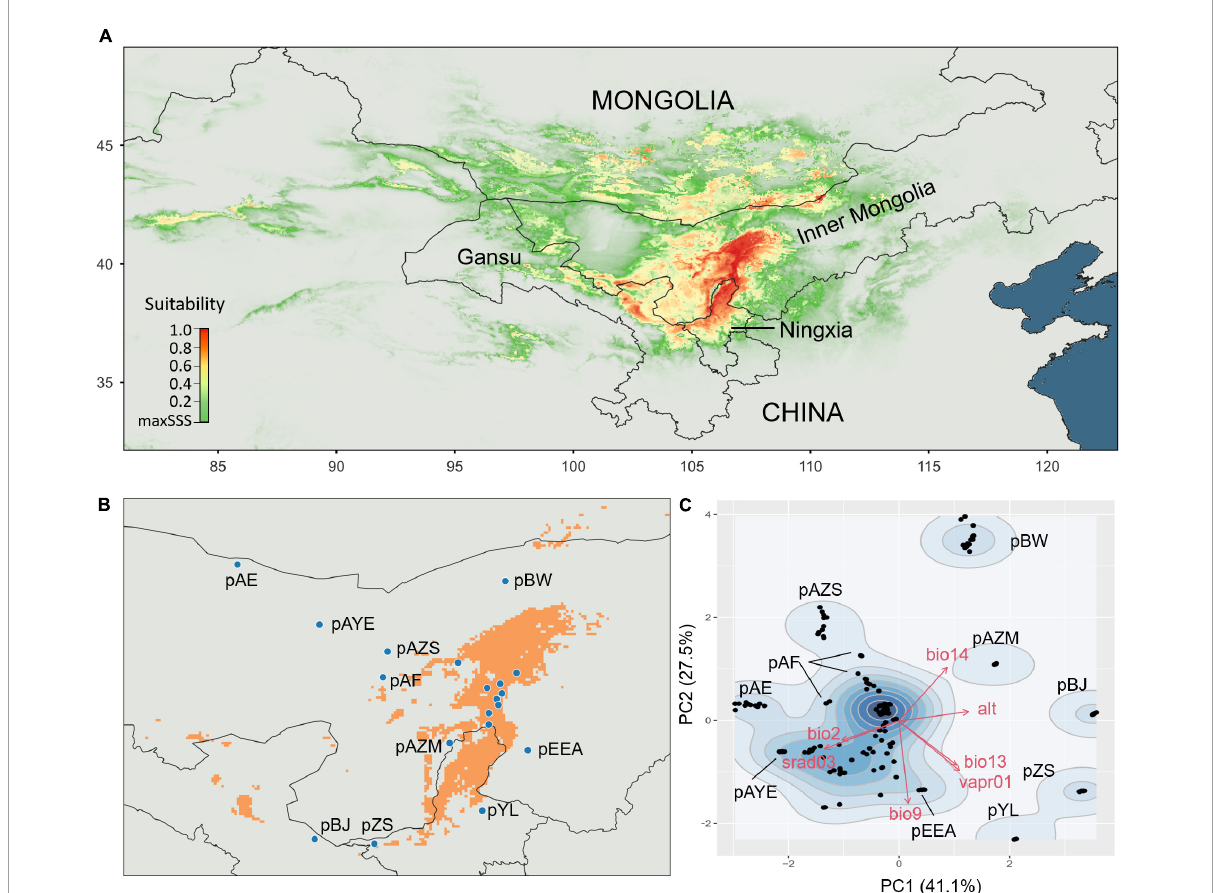
FIGURE2 Ecological niche modelling (ENM) and climate niches. (A) ENM showing the potential distribution of Ammopiptanthus mongolicus . (B) The estimated suitable distribution of A. mongolicus . The orange colour illustrates the suitable ranges at a criterion > 0.75. Peripheral populations outside the suitable ranges are explicitly labelled. (C) Contour plot mapped in the PCA space showing the divergence of climate niches among populations. Peripheral populations are